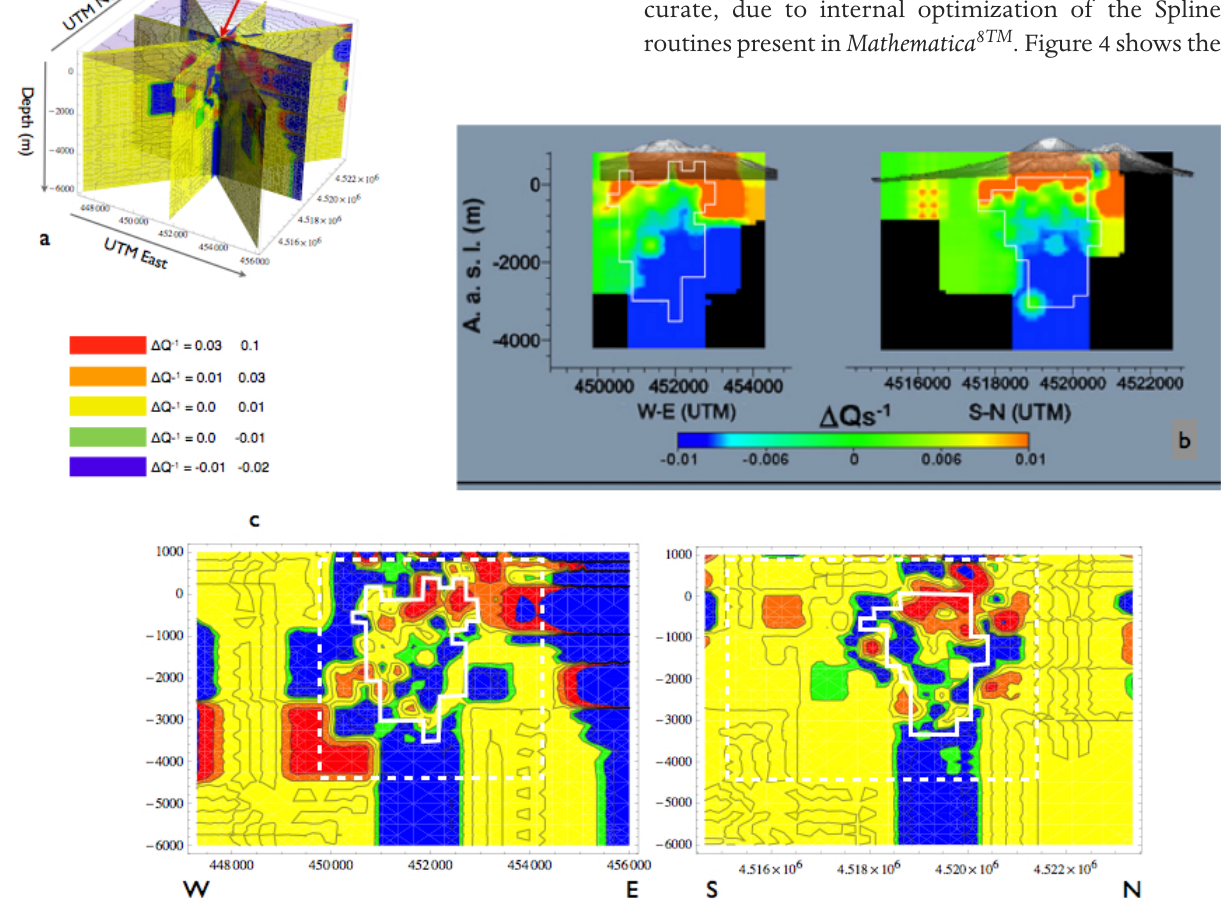
Figure 3. (a) 3D S-wave differential total-attenuation obtained through SeeVes . The values inside a 2-km wide strip along the borders of the box are artifacts due to the process of interpolation; (b) W-E and S-N sections of the differential attenuation redrawn by De Siena et al. [2009]; (c) W-E and S-N sections of the differential attenuation obtained using SeeVes . To these last images we have reported the borders of the volume with the resolution of 300 m (white lines) and the borders of the volume with 900 m resolution (dashed white